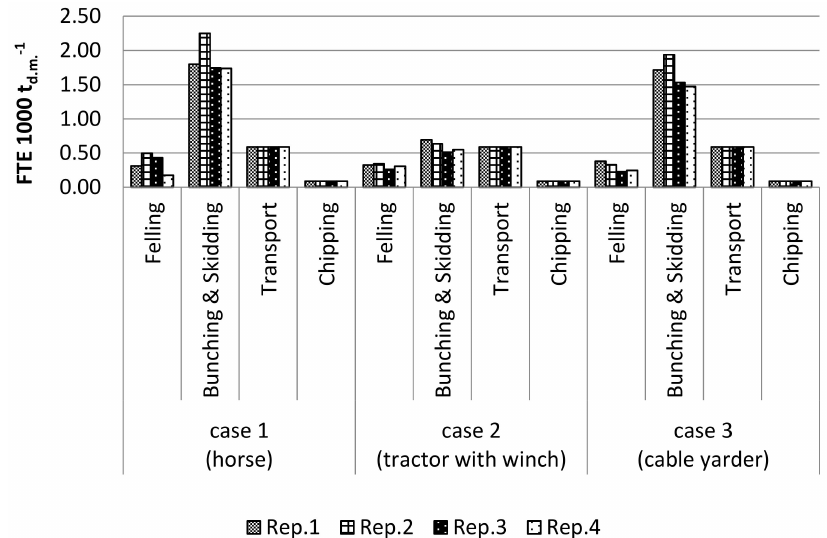
Figure 5. Resulting employment rate per process and case, in FTE 1000 t d.m. − 1 . Note: FTE = full time equivalent (1500 h year − 1 for workers and 1200 h year − 1 for